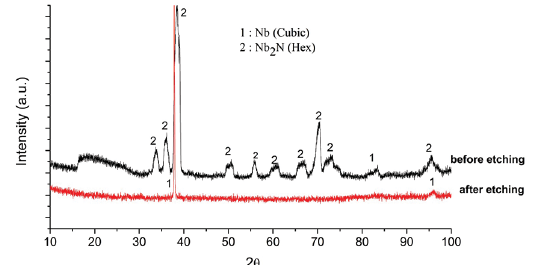
Figure 8. XRD for Nb sample heated at 900 °C and treated via pulses